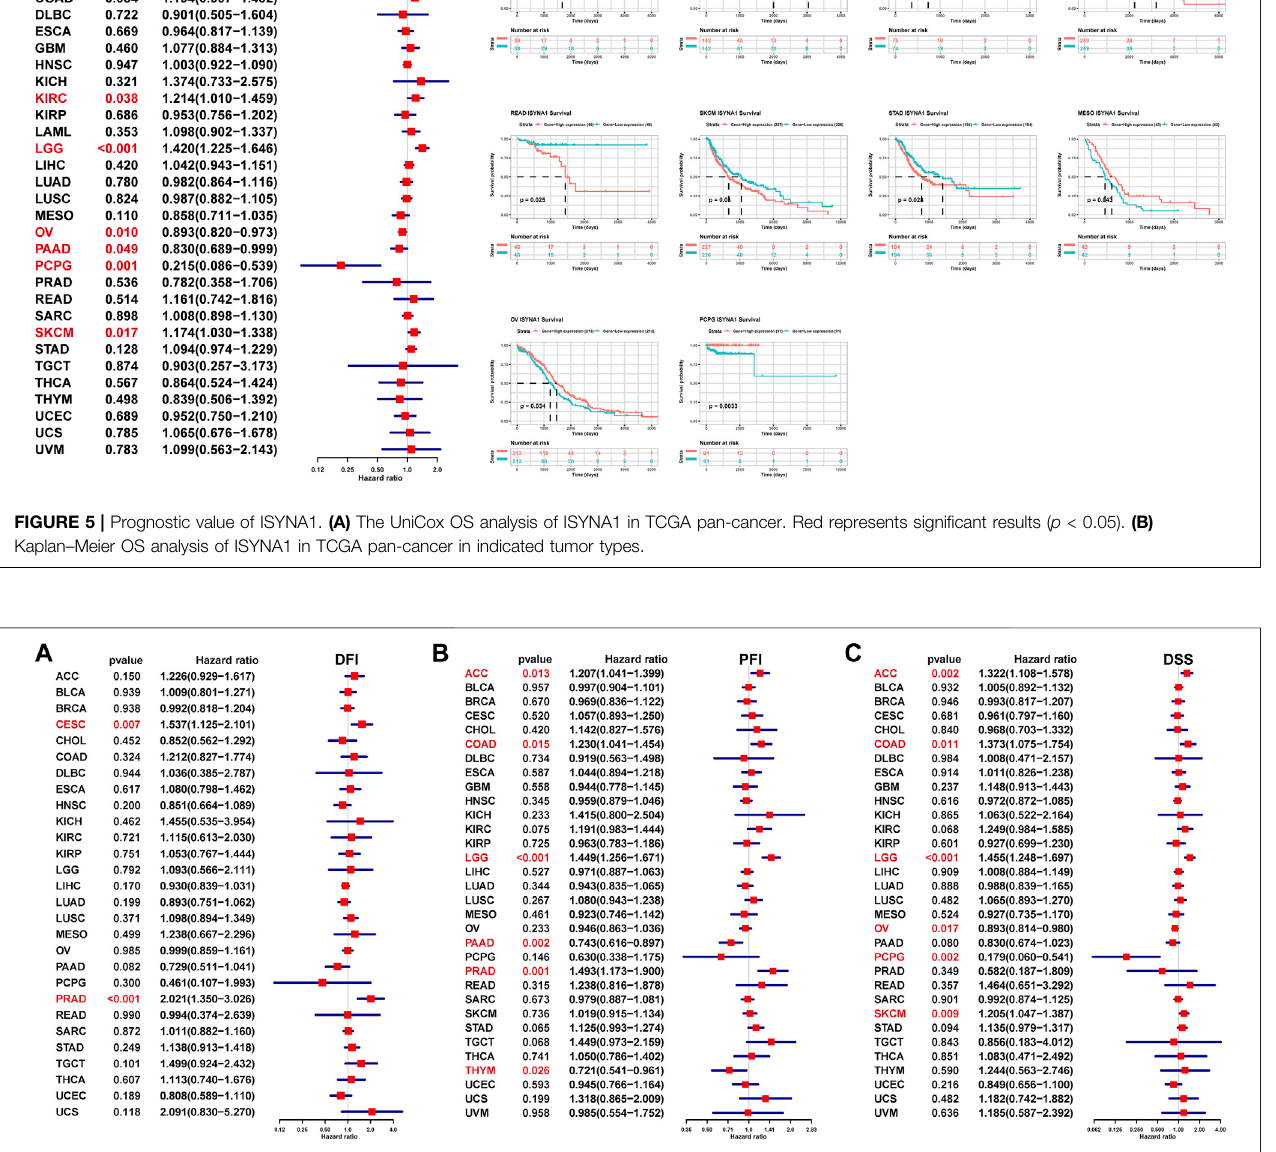
FIGURE6| Prognostic valueofISYNA1inpredictingDFI,PFI, and DSS. (A) The UniCoxresults ofDFI wereshown using forest plots. (B) TheUniCox resultsofPFI were shown using forest plots. (C) The UniCox results of DSS were shown using forest plots.